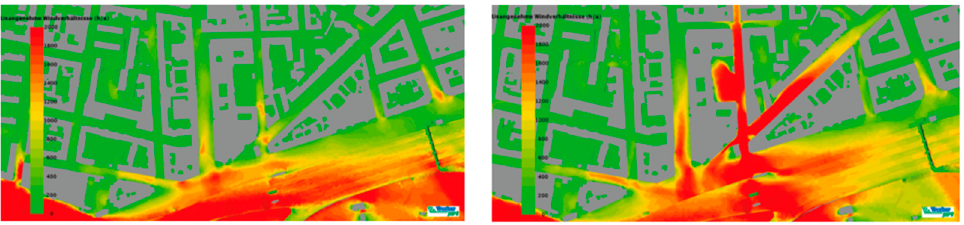
Figure 17. Changes in wind comfort for westerly wind direction for base case ( left ) and a high-rise buildings densification scenario ( right ).